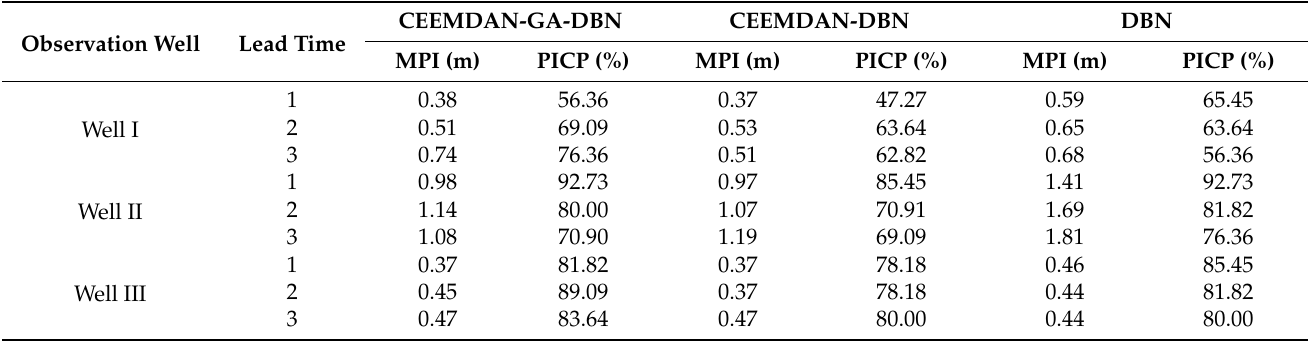
Table 7. Uncertainty analysis for the 1-, 2- and 3-month ahead GWL forecasts of the CEEMDAN-GA-DBN, CEEMDAN- DBN and DBN models at 90% confidence